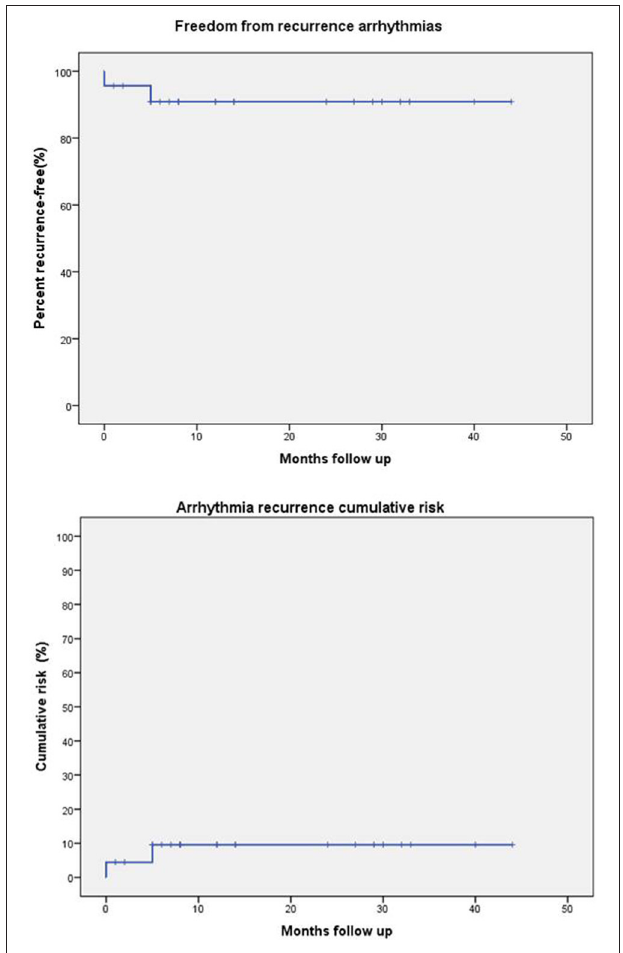
FIGURE 1 | Freedom from recurrence of arrhythmia and cumulative risk of recurrence.